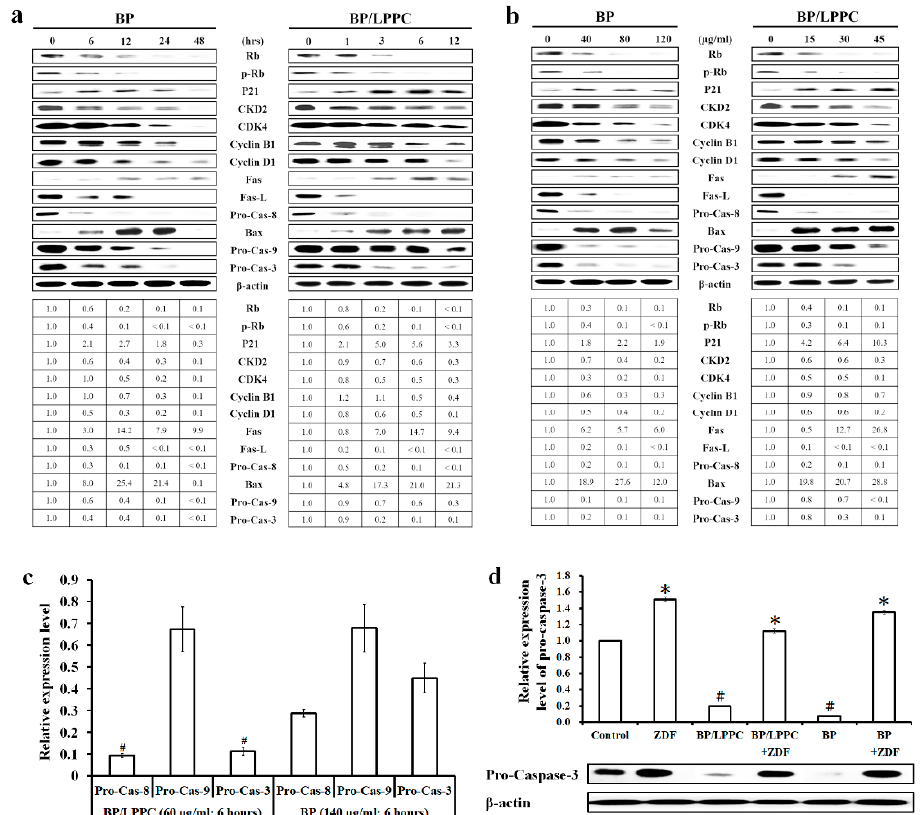
Figure 4. The molecular mechanism underlying the antitumor effects of BP/LPPC in HT-29 cells. ( a,b ) HT-29 cells were treated with BP/LPPC or BP at different doses and for different times, and the levels of cell cycle- and apoptosis-related proteins were detected using western blotting. ( c ) Comparison of the levels of the Pro-Caspase-8, 9 and 3 proteins between cells treated with BP/LPPC (60 μ g/mL) and BP (140 μ g/mL) at 6 h. # p < 0.05 compared with the BP group, with a significant decrease. ( d ) Cells were pretreated with the Caspase-3 inhibitor Z-DEVD-FMK (1 μ M), and then treated with 60 μ g/mL BP/LPPC (6 h) or 140 μ g/mL BP (24 h). The level of the Pro-Caspase-3 protein was analyzed using western blotting. # p < 0.05 compared with the control, with a significant decrease. * p < 0.05 compared with no inhibitor pretreatment in the BP/LPPC or BP group, with a significant